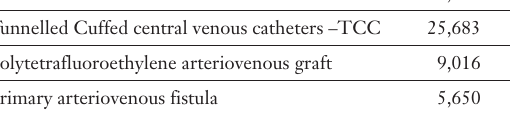
Type of vascular ac- cess and BSI-related cost of hospitalisa- tion/admission [2, 3].